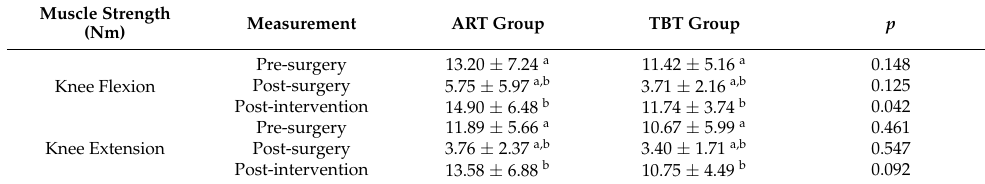
Table 3. Comparison of strengthening within and between groups.